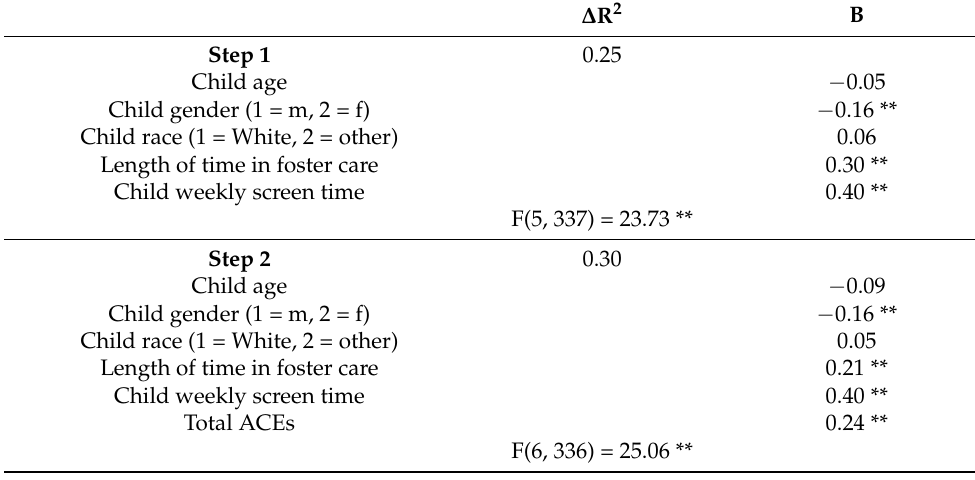
Table 3. The association between ACEs and problematic media